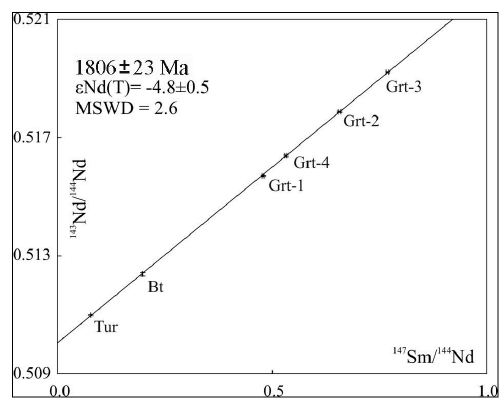
Figure 14. Sm-Nd isotopic data for garnet (Grt)-tourmaline (Tur)-biotite (Bt) from diorite-gneiss of the DW block. Table 7. Sm-Nd isotopic data for minerals from rocks of the DW